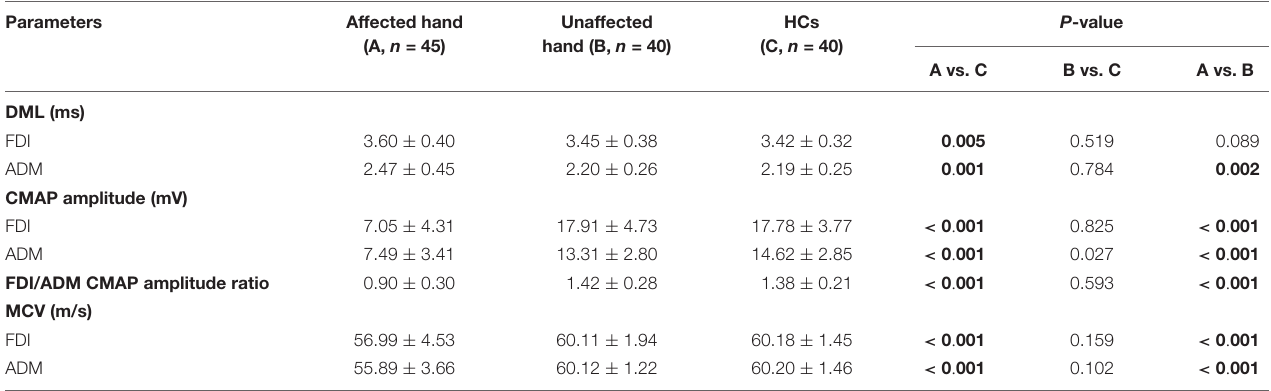
TABLE 2 | Results of nerve conduction studies and split-hand. Parameters